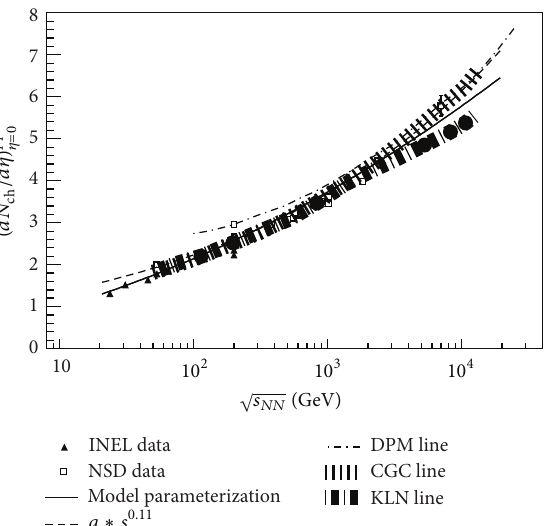
Figure 2: Variations of the charged hadrons pseudorapidity density at midrapidity in 𝑝 - 𝑝 collisions as a function of c. m. energy. Data is taken from [99–112].